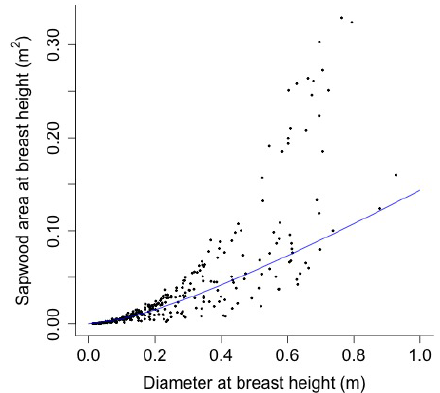
Figure D16. Sapwood area at breast height model fit to BAAD for Acer